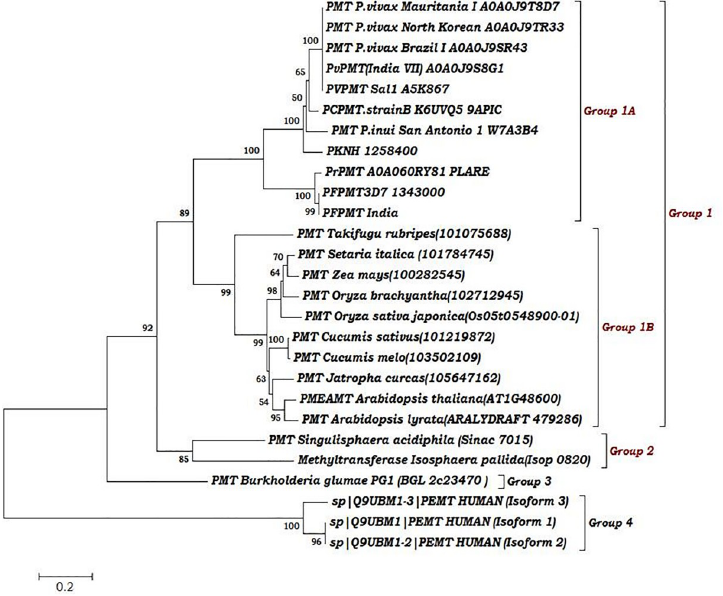
Fig 3. Phylogeny showed with all Plasmodium and other species orthologues from KEGG and EuPathDB along with human PtdEpmt. https://doi.org/10.1371/journal.pone.0221032.g003 compounds before docking is a good approach. Compound library was pre filtered through Lipinski rule of five and ADMET using DSv3 .5 and promiscuous compounds using false posi- tive remover to save time and experimental cost. False positive remover identifies and elimi- nates the compounds with reactive functional groups like compounds containing Table 2. Docking score and binding energy of selected compounds tabulated with interacting amino acids and Virtual ADME parameters as per Lipinski rule of five of selected compounds and virtual toxic physicochemical parameter analysis of selected compounds. Compound ID ASN.1 ASN.2